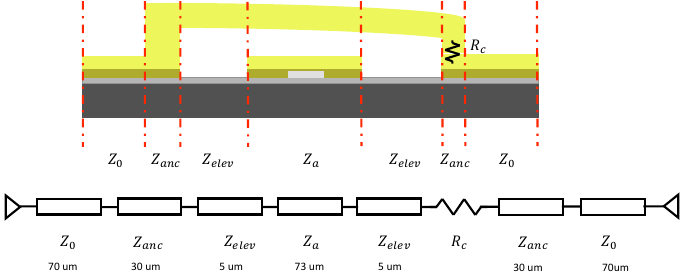
Figure 11. A comprehensive transmission line circuit model for ON state MEMS